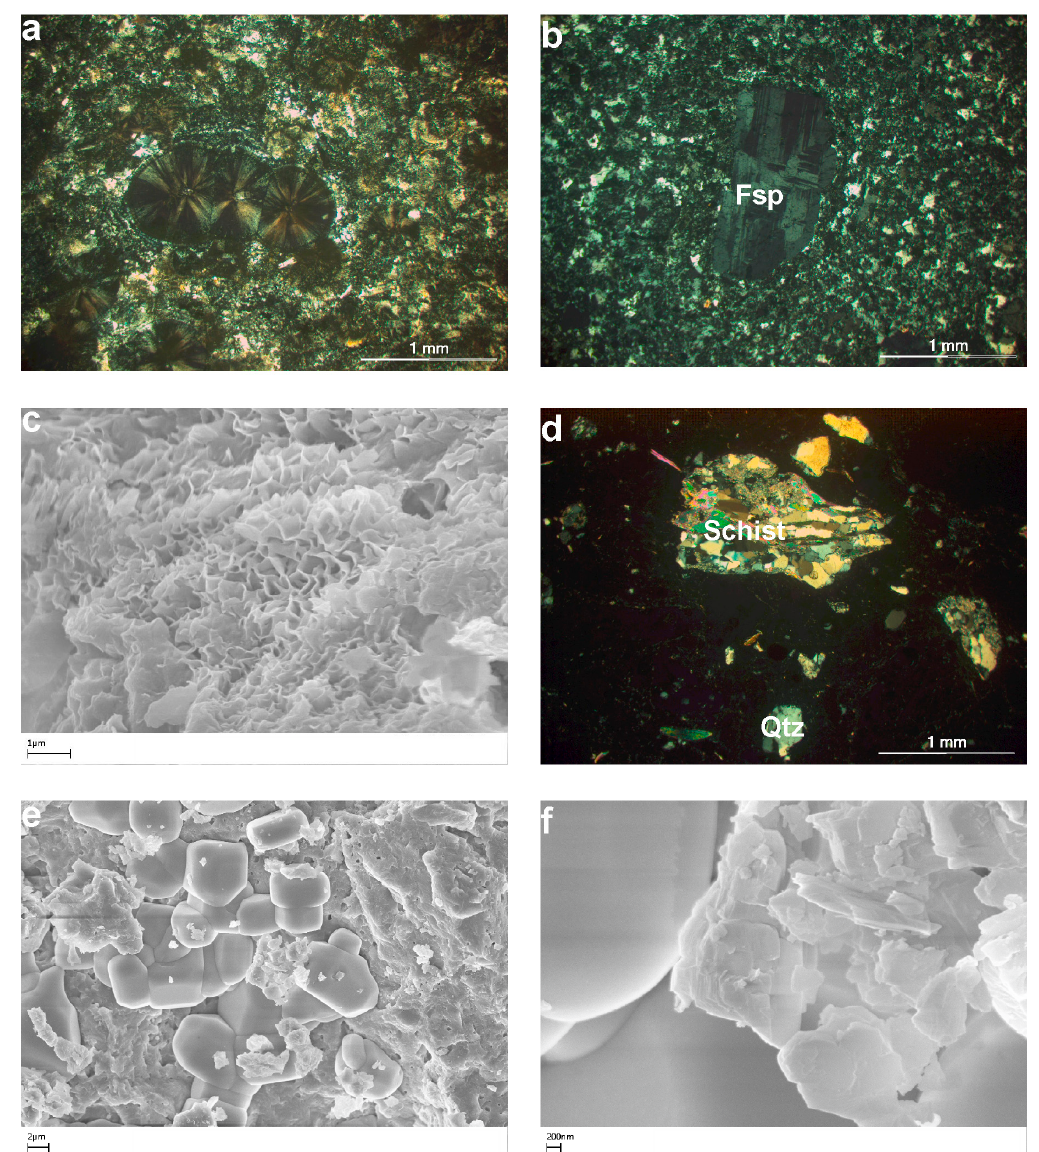
Figure 6. ( a ) Photomicrograph of rhyolitic tuff shows sferolites of quartz (sample of area 1, XPL); ( b ) Photomicrograph of rhyolite shows a porphyroclast of feldspar (Fsp) in a microcrystalic groundmass (sample of area 2, XPL); ( c ) SEM image of smectite flakes in a rhyolitic tuff (sample of area 1); ( d ) Photomicrograph of rhyolitic tuff shows a fragment of mica schist and quartz (Qtz) in the groundmass (sample of area 1, XPL); ( e ) SEM image of halite, presented as not well formed (sample of area 1); ( f ) SEM image of illite flakes on halite crystals (sample of area 1).